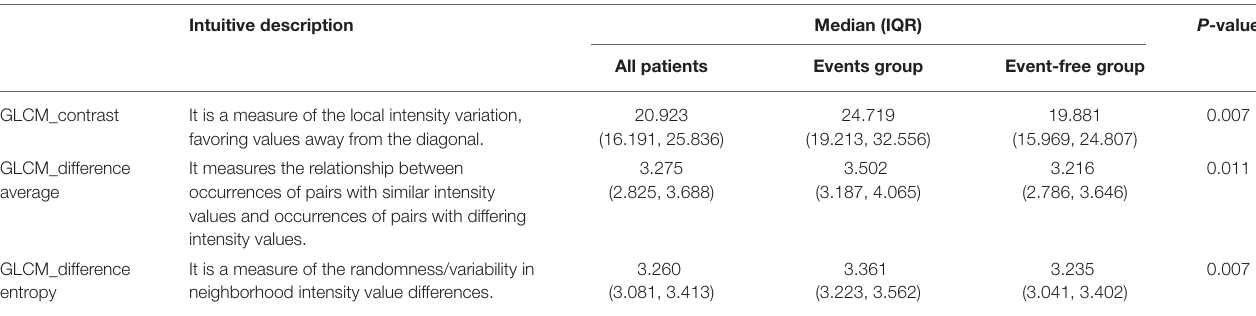
TABLE 3 | Characteristics of employed texture features for survival analysis. Intuitive